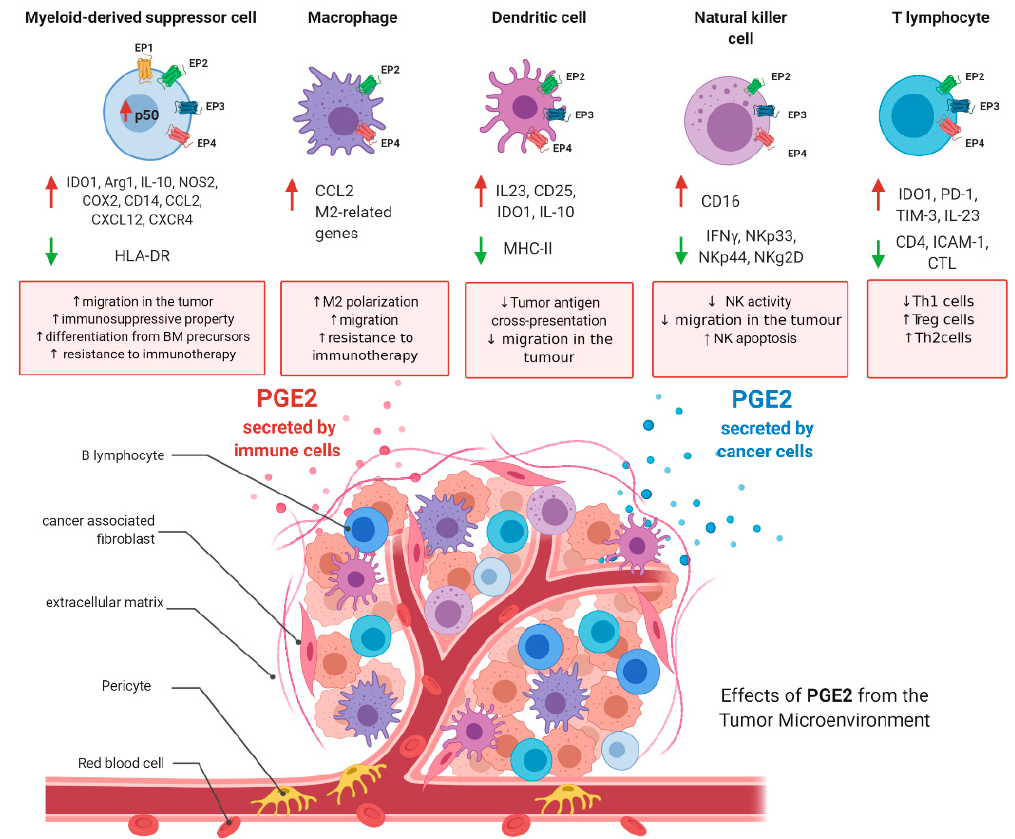
Figure 3. PGE2 roles in immunosuppressive tumoral niche. PGE2 levels are increased in the tumoral microenvironment. PGE2 is secreted by cancer cells and immune cells. In the figure are depicted the main functions of PGE2 in myeloid-derived suppressor cells, tumor-associated macrophages, dendritic cells, natural killer (NK) cells, and T-cells. Figure has been generated using